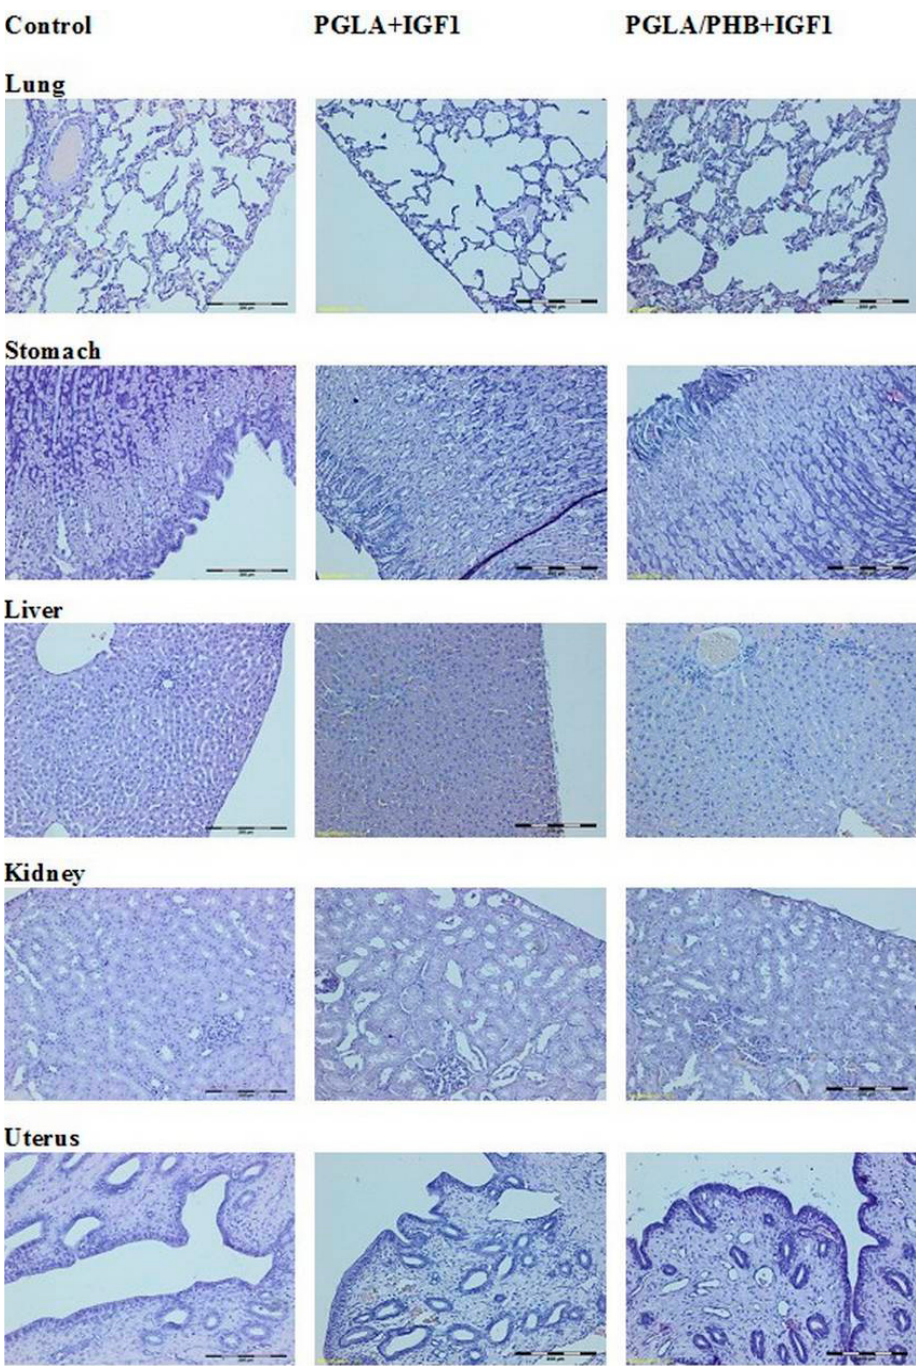
Figure 17. Microscopic images of internal organs (Dye HE. MG 100×).